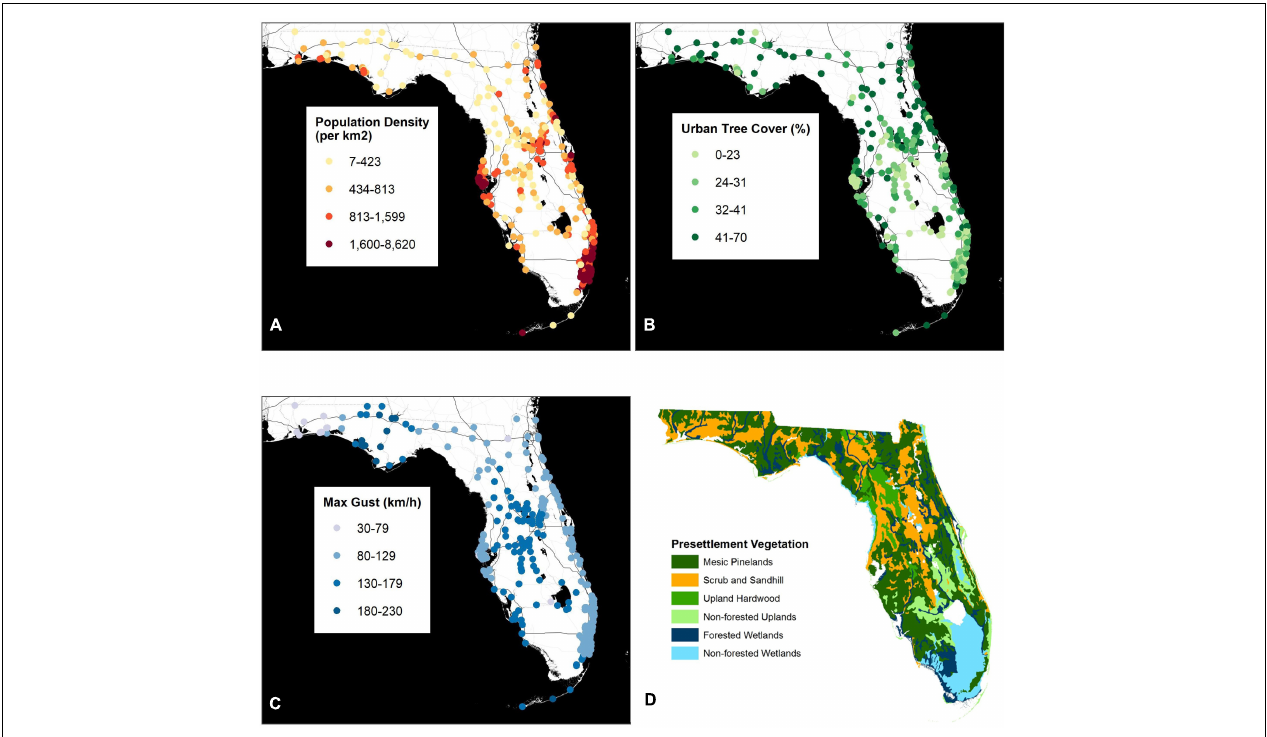
FIGURE 2 | Population density (A) , urban tree cover (B) , maximum hurricane gust speed (C) , and historic landcover (D) among the 300 Florida (United States) municipalities included in this study. Historic landcover is a reprinting of the pre-settlement map published by Volk et al. (2017). Image used with